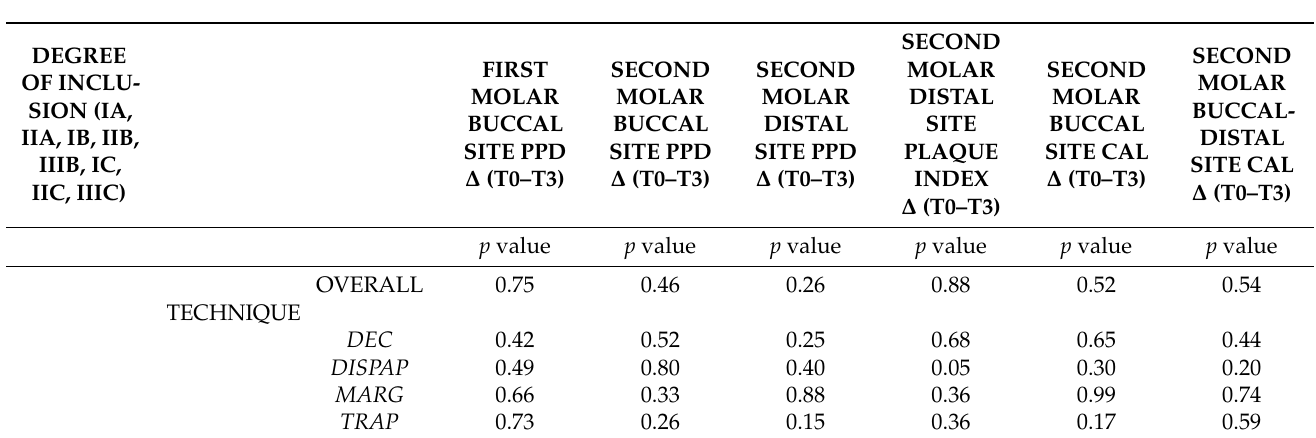
Table 3. Analysis of soft tissues indexes of periodontal healing between T0 and T3, according to pre- operative degree of inclusion, for overall sample and comparing different flaps techniques; p values are